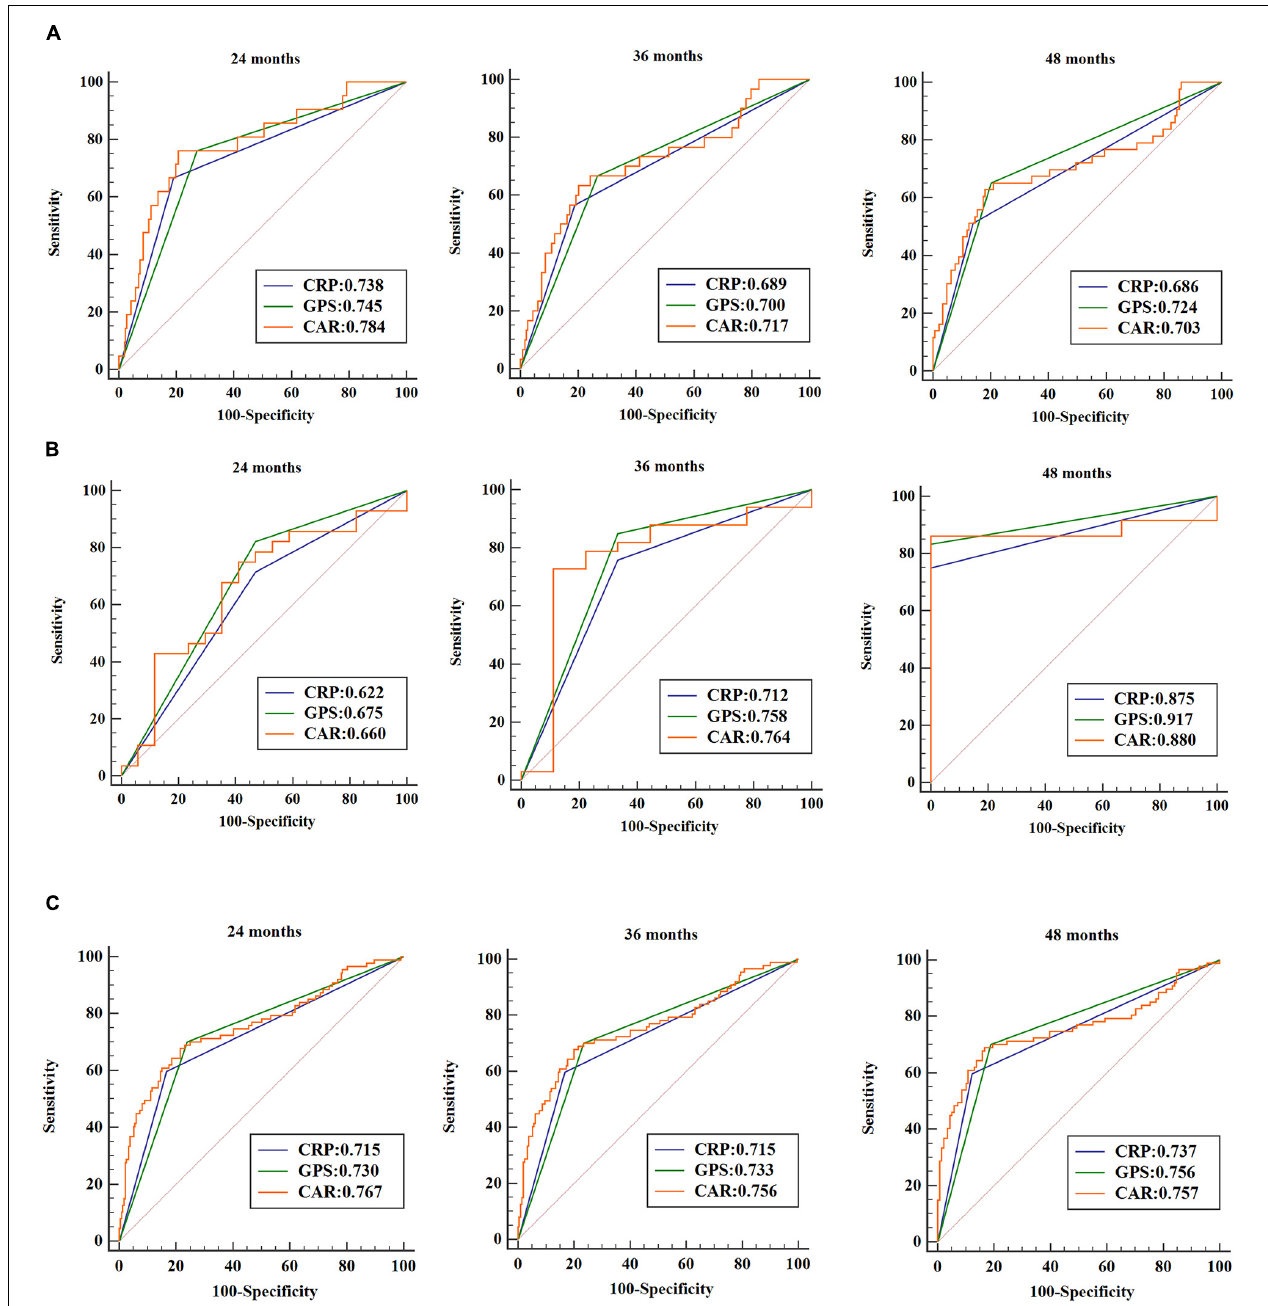
FIGURE 5 | Receiver operating characteristic (ROC) curves were used to analyze patient survival at the 24-, 36-, and 48-month follow-up periods. The areas under the ROC curve (AUCs) assessed the discriminative ability of each inflammation-based prognostic score in stage I–III colorectal cancer (CRC) patients (A) , in colorectal liver metastasis (CRLM) patients (B) , and in all CRC patients (C)